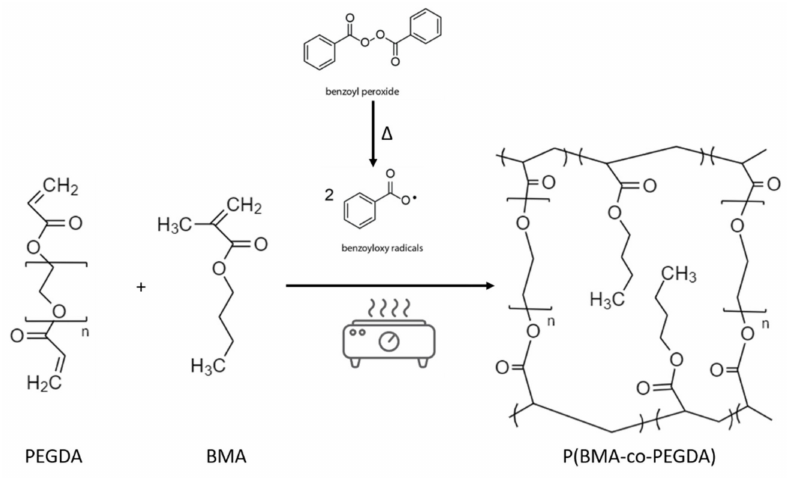
Figure 1. Schematic representation of the polymerization